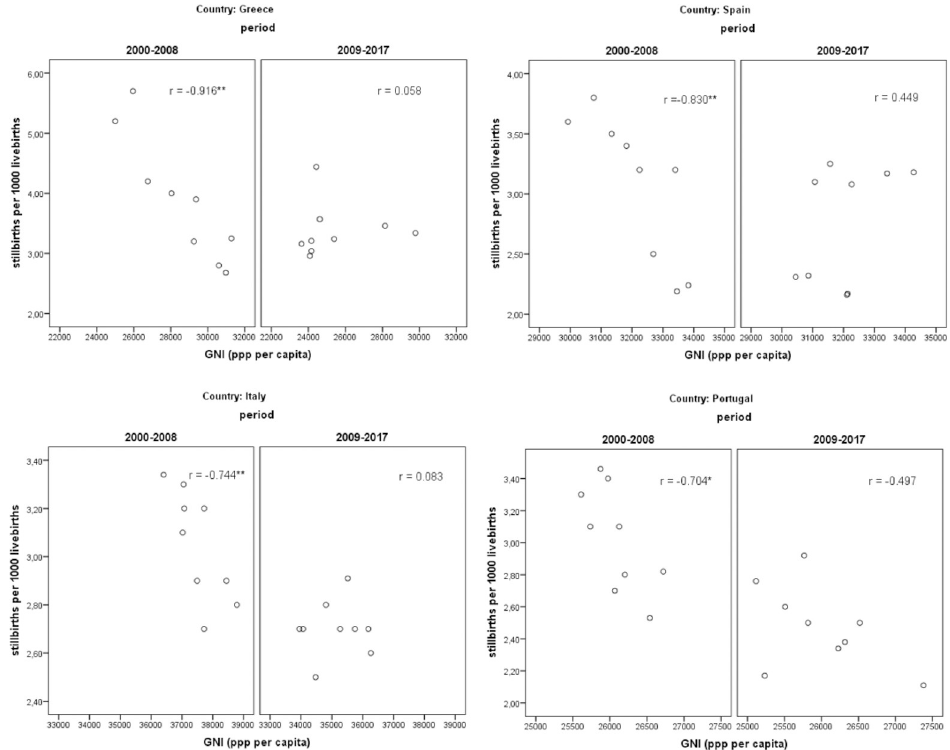
Fig 3. Scatter plots and correlation coefficients between stillbirth ratios and Gross National Income (GNI). ( �� statistically significant at 0.01 � statistically significant at 0.05).